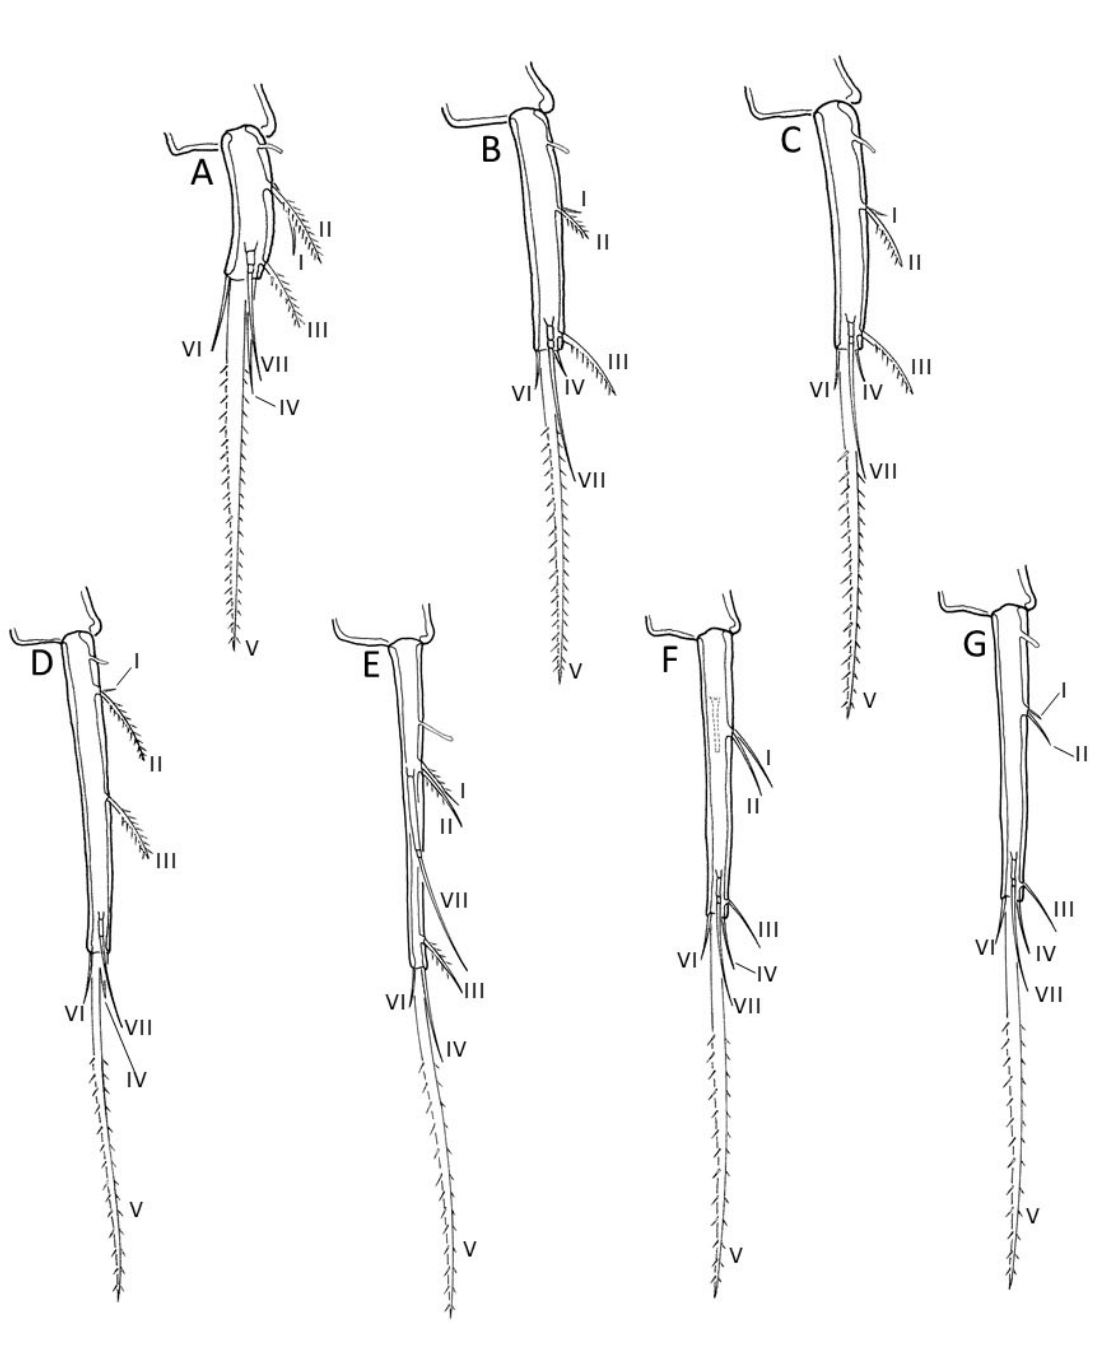
Fig. 17. Schemes of the general shape of the furcal rami in the Ceratonotus group. A . Touphapleura